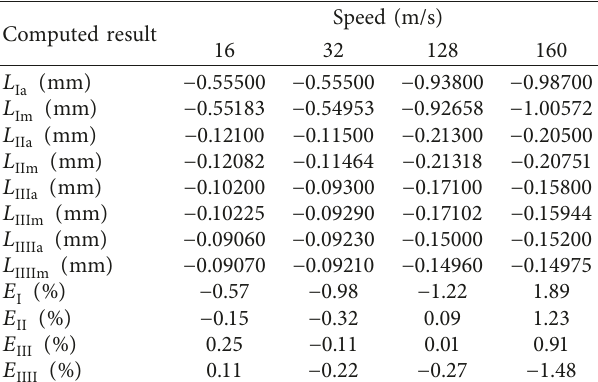
Table 1: Comparison of the dynamic response peaks of the midspan deflections of the four-layer beam